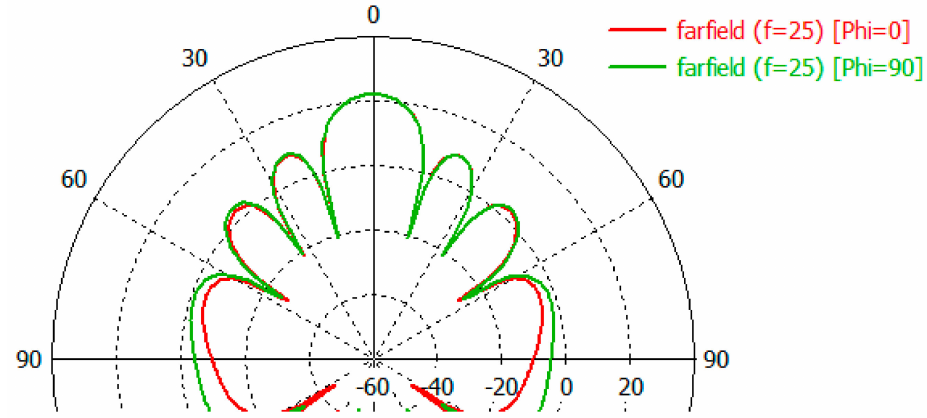
Figure 7. The E and H plane radiation pattern of rectangular 6 × 6 array.